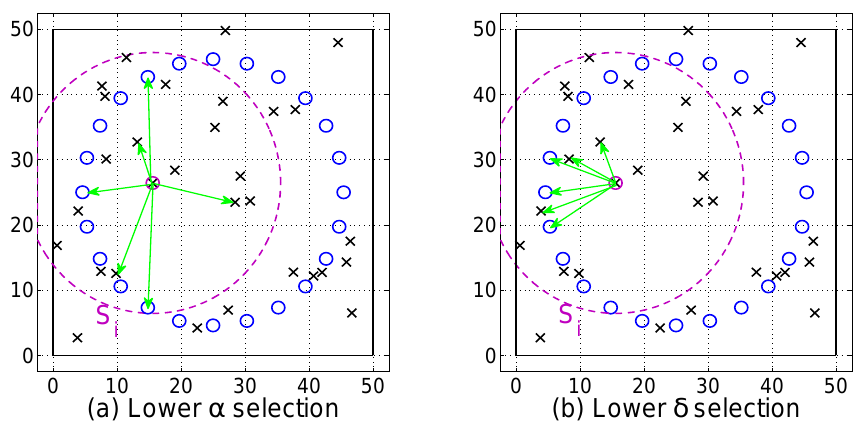
Figure 5. Example of both node selection methods.